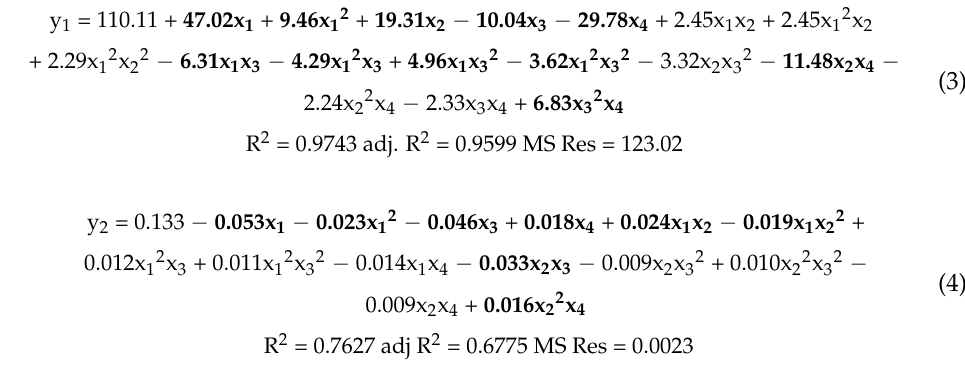
Table 4. Physical parameters of